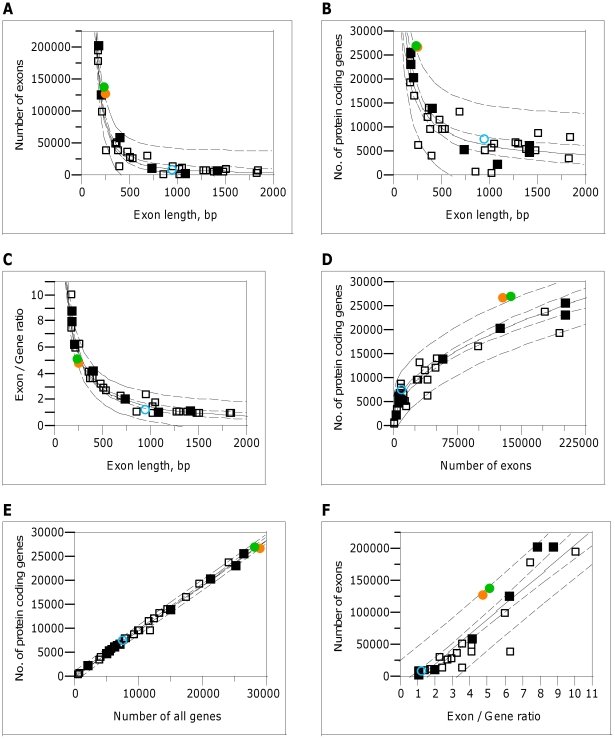
Correlations between selected genome parameters.Correlations of number of exons and mean exon length (A),
number of protein coding genes and mean exon length (B),
exon/gene ratio and mean exon length (C), number of protein
coding genes and number of exons (D), number of protein
coding genes and number of all genes (E), and number of
exons and exon/gene ratio (F) based on 36 species studied.
The most annotated 10 species are represented by solid markers. Green,
orange and blue markers correspond to Arabidopsis
thaliana, Oryza sativa and
Ostreococcus ‘lucimarinus’,
respectively. 95% confidence intervals are presented for both
population (internal dashed line) and individual (external dashed line)
levels.